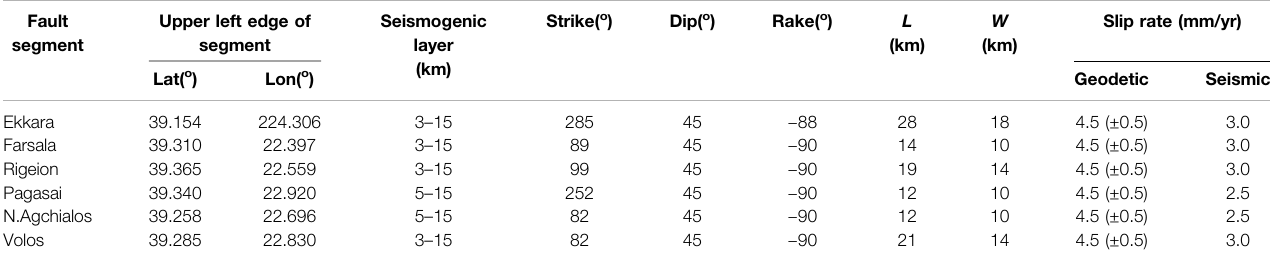
TABLE 2 | Geometrical and kinematic parameters of the fault network model used in the simulation application of the Southern Thessaly Fault Zone. Fault Upper left edge of segment segment Lat( o ) Lon( o ) Geodetic Seismic